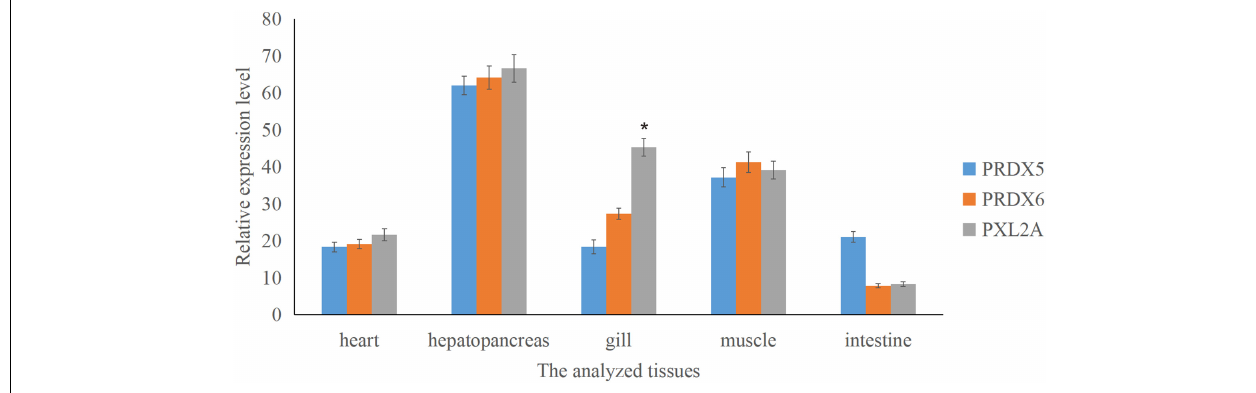
FIGURE 7 | Relative expression of Prx5, Prx6, and PXL2A genes in different tissues of C. japonica is shown. The abscissa is the heart, hepatopancreas, gills, muscles, and intestines. The bar chart shows significant differences (* P < 0.05).